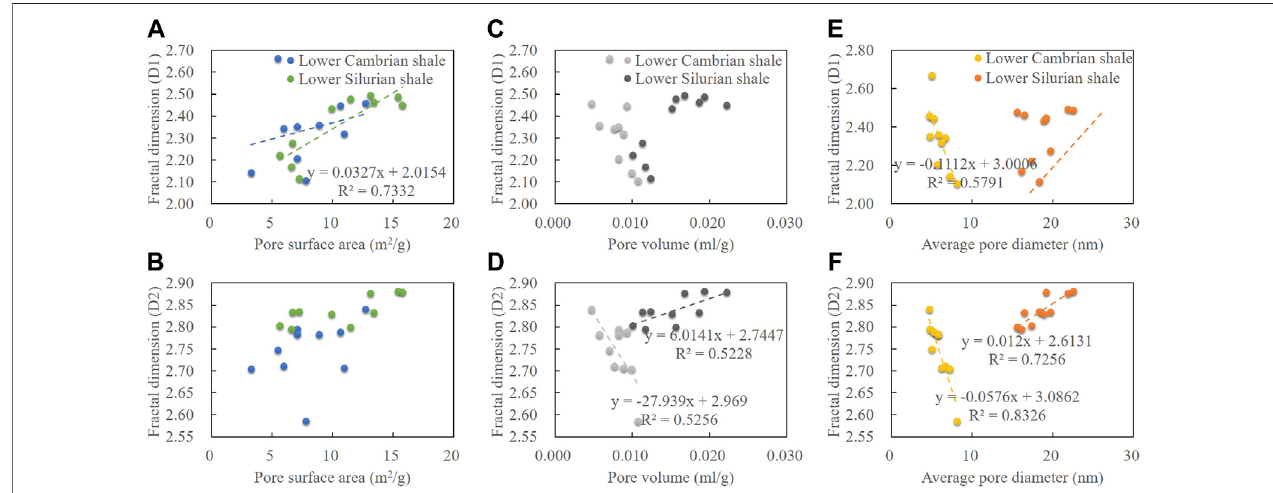
FIGURE 11 | Correlations between fractal dimension and pore surface area (A,B) , pore volume (C,D), and average pore diameter (E,F) .